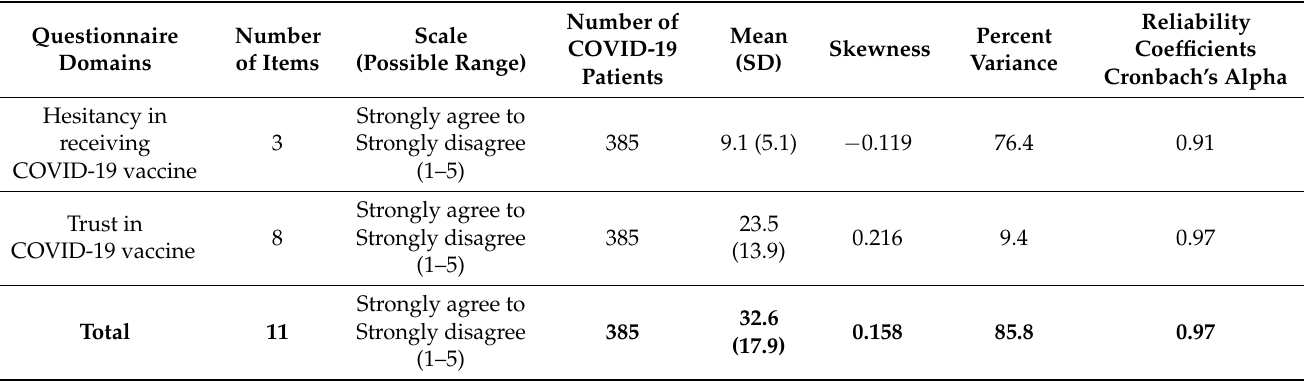
Table 3. Number of items and respondents, reliability, and score distributions by domain included in the vaccine hesitancy questionnaire.